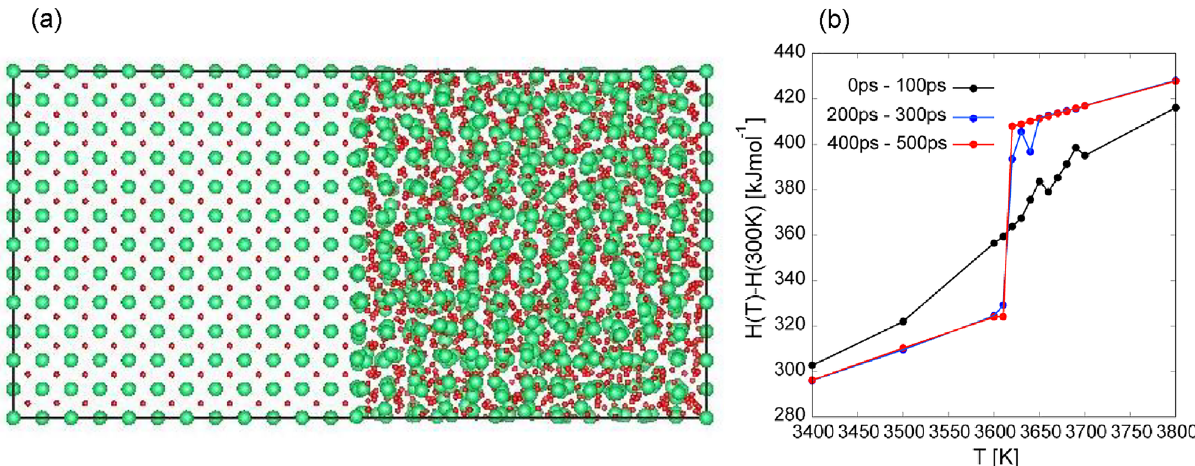
Figure 4. ( a ) Configuration of 6 × 6 × 12 supercell including solid (left) and liquid phase (right). ( b ) Temperature dependence of the enthalpy obtained by the two-phase simulation approach using MLMD with BPNN-SCAN. The blue filled circles and the open green squares and red circles represent the enthalpies calculated in the periods as 0 ps to 100 ps, 200 ps to 300 ps and 400 ps to 500 ps, respectively.